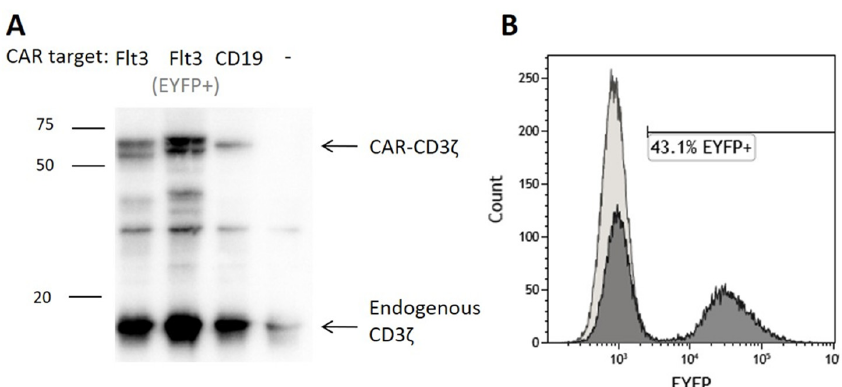
Figure 4. Generation of Flt3-CAR Jurkat cells. ( A ) Western blot demonstrating synthesis of the chimeric receptor proteins in transduced cells. High bands corresponding to CD3 ζ domain of the chimeric receptors (50–60 kDa) are observed for transduced Jurkat cells and not observed for non- transduced Jurkat cells. Lower bands corresponding to CD3 ζ part of the endogenous T cell receptor complex (16 kDa) are observed in all lanes. ( B ) A representative flow cytometry histogram showing EYFP synthesis in Flt3-CAR Jurkat cells on day 7 after transduction.